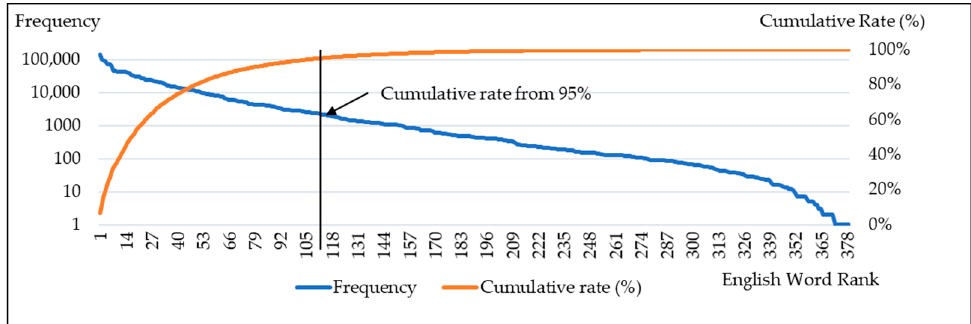
Figure 8. Finding very rare English words (domain adaptation 1); the frequency on a log scale for the left y-axis (dotted line); the cumulative rate (%) for the right y-axis (solid line); English word rank for the horizontal x-axis.